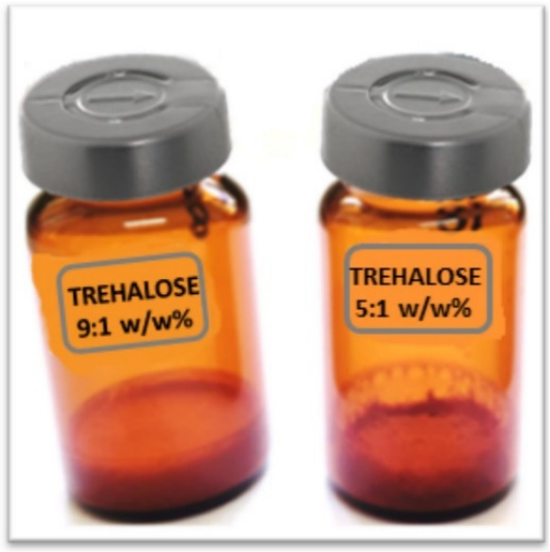
Figure 2. Freeze-dried LCFL-PTX/DXR resulting from freeze-drying cycles 1 and 2. Freeze-dried LCFL-PTX/DXR containing trehalose 9:1 w / w maintained the structure and volume during the freeze-drying process forming an elegant cake. Freeze-dried LCFL-PTX/DXR containing trehalose 5:1 w / w suffered shrink.